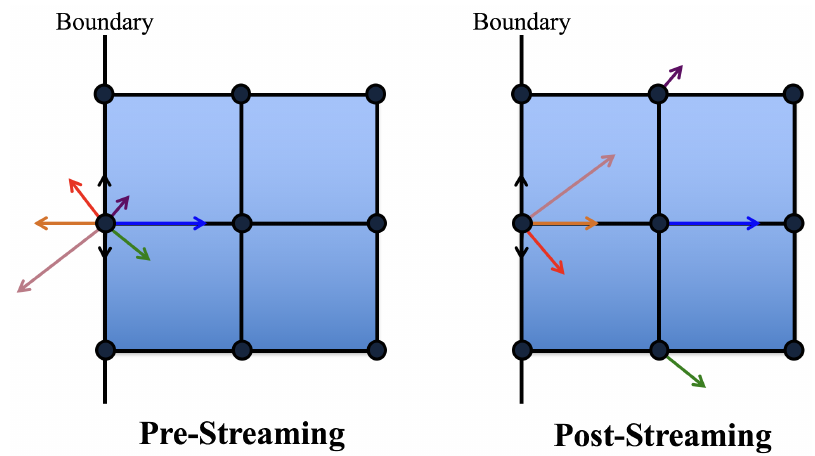
Figure A3. Illustration of bounce-back boundary conditions. During the pre-streaming step there are microscopic velocities set on the boundary and then they are reversed during the streaming